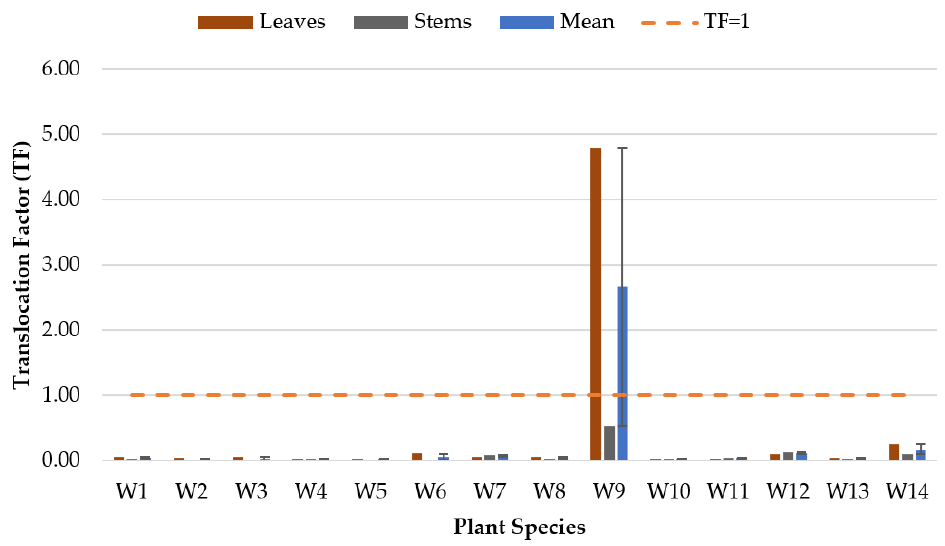
Figure 8. Translocation factor (TF) of iron (Fe) in the phytoremediation of domestic sewage meso- cosms using various tropical plants.